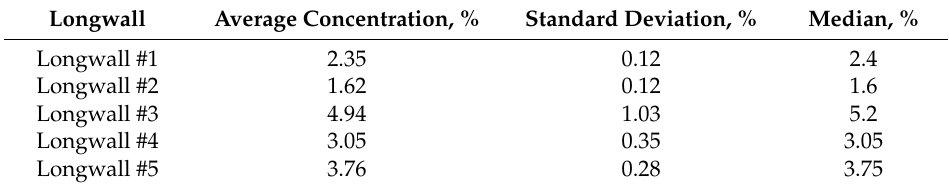
Table 2. A summary of the average values of measurement results for crystalline silica in the dust. Longwall